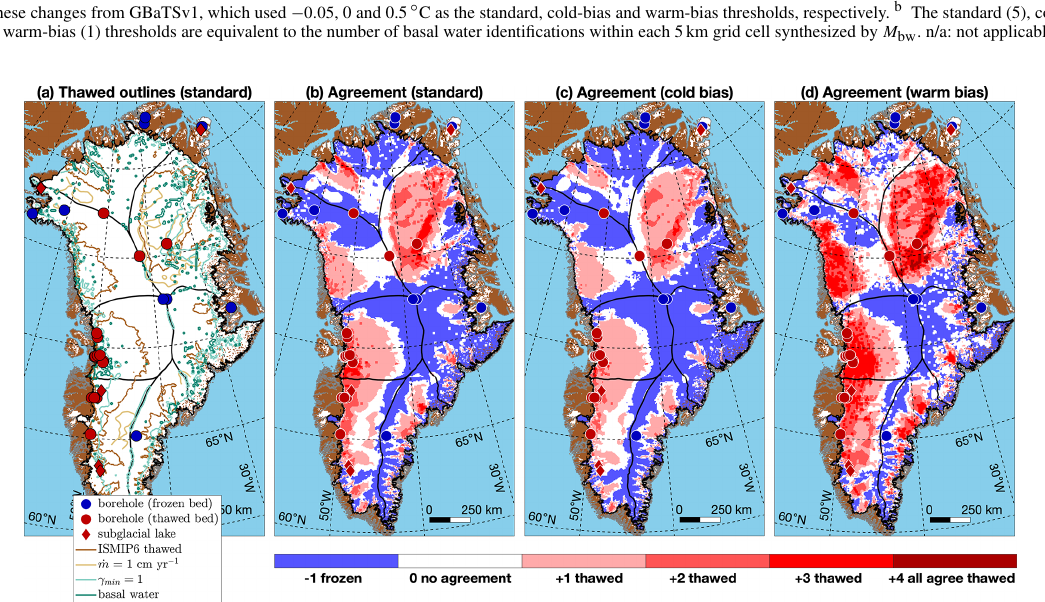
Figure 7. (a) Outlines of a thawed GrIS bed for the four methods considered in this study (Figs. 3, 4, 5d, 6c). For the ISMIP6 agreement, their outline denotes where at least 7 of the 10 models agree that the bed is thawed. (b) Agreement between the four methods regarding the basal thermal state using standard thresholds ( S ; Table 3). (c, d) Cold- and warm-bias agreement ( S cold and S warm , respectively) determined using each method’s confidence bounds or ad hoc uncertainty estimates. Because only one method constrains where the bed is frozen (thermomechanical models) but all four constrain where it is thawed, the range of possible values is − 1 (frozen) to + 4 (all